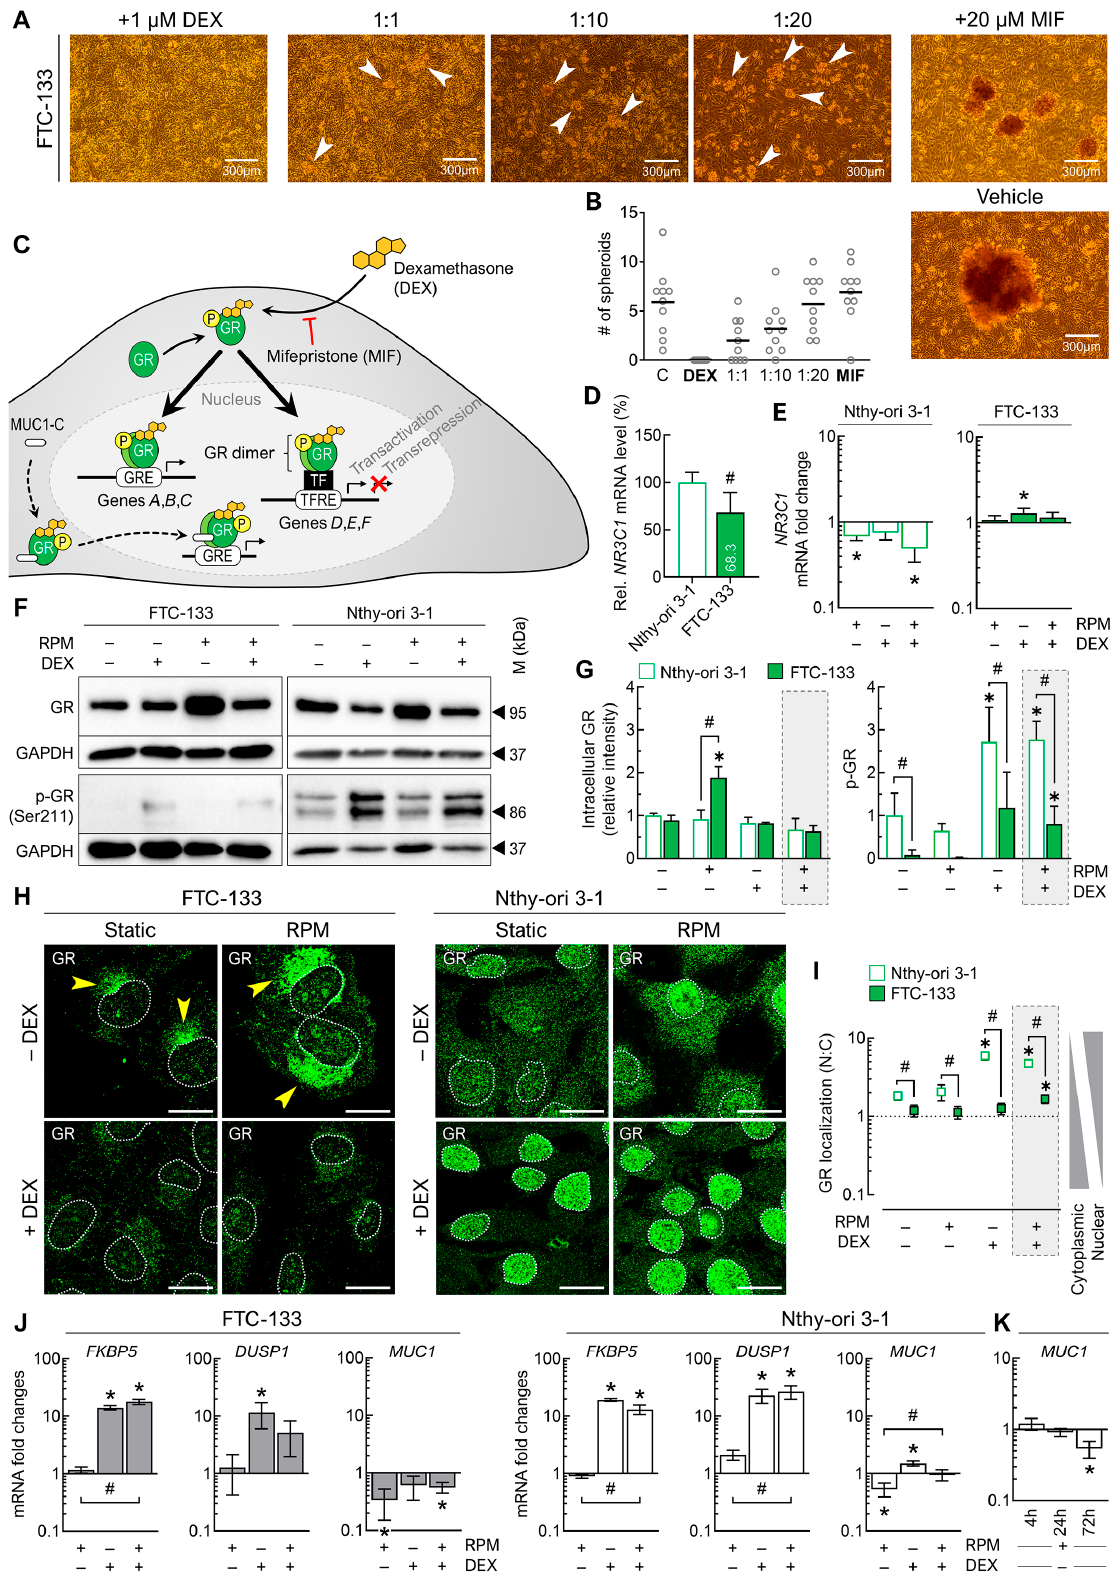
Figure 7. Effect of DEX on the glucocorticoid receptor (GR) and GR signaling in FTC-133 and Nthy-ori 3-1 cells after 3 days. ( A ) Spheroid formation (white arrows) of FTC-133 cells in the presence of 1 µ M DEX and different concentrations (1–20 µ M) of the competitive GR inhibitor mifepristone (MIF); ( B ) number of FTC-133 spheroids formed on the RPM in the presence of DEX and